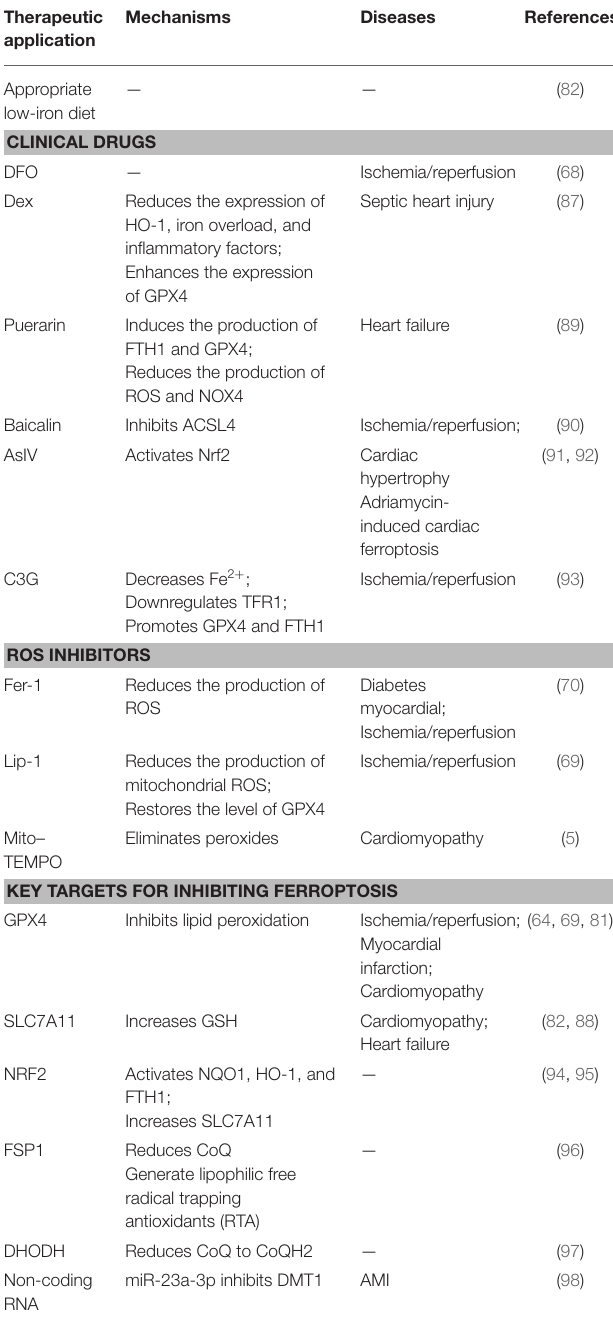
TABLE 1 | Strategies to target ferroptosis in cardiovascular